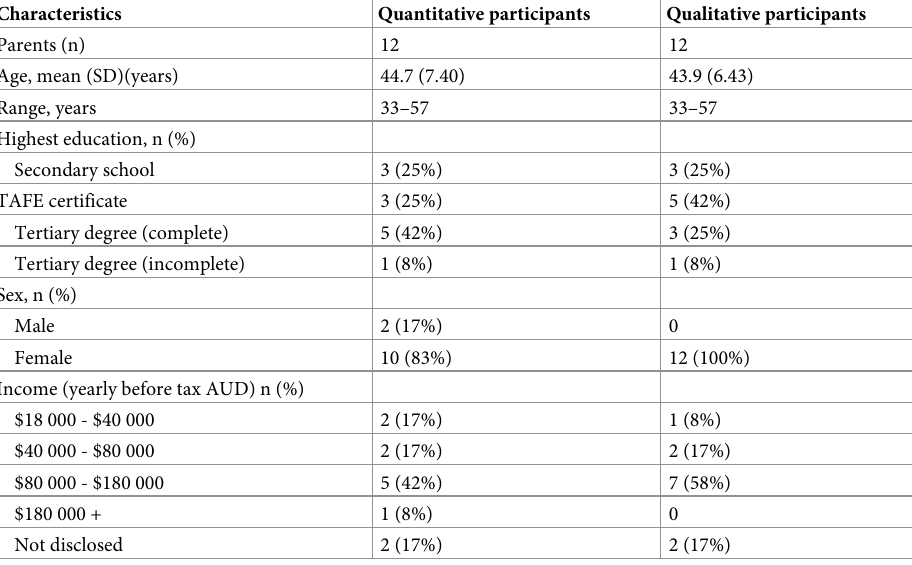
Table 3. Characteristics of parents of adolescents who participated in technology